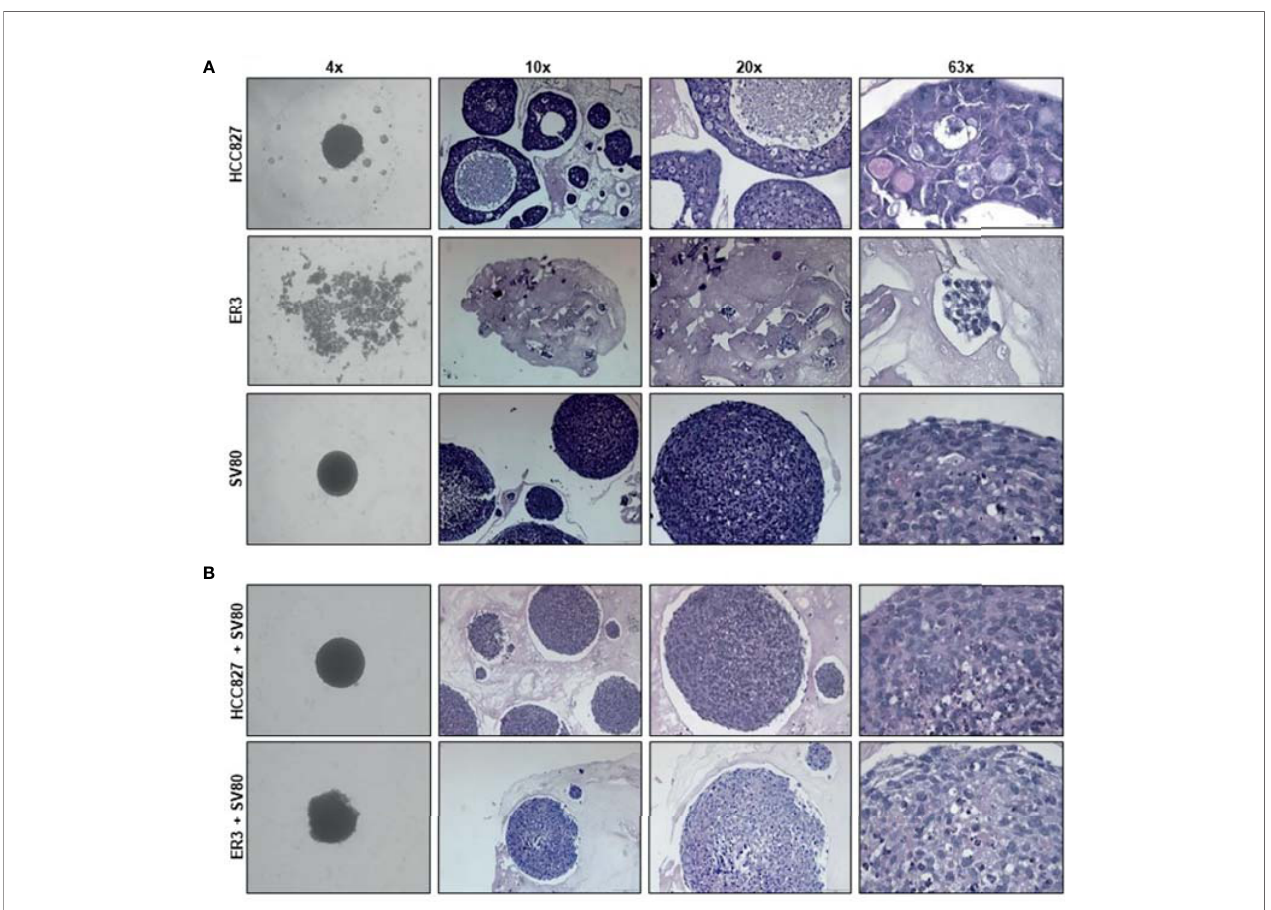
FIGURE 4 | Histological characteristics of homotypic and heterotypic co-culture spheroids. (A) Monoculture spheroids of HCC827 parental cells, the erlotinib- resistant clone ER3, and the fi broblast cell line SV80 were cultured for seven days in ultra-low attachment plates before fi xation, paraf fi n embedding, and sectioning. Spheroids are stained with hematoxylin and eosin (H&E). ER3 cells formed only loosely attached clusters of cells captured in a thrombin gel before paraf fi n embedding. (B) Heterotypic co-culture spheroids consisting of SV80 fi broblasts and HCC827 parental or ER3 cells in a 2:1 ratio. Spheroids were cultured for seven days in ultra-low attachment plates before fi xation, paraf fi n embedding, and sectioning. Spheroids are stained with H&E. The light pink matrix surrounding the loosely attached cell clusters of ER cells, and the spheroids is the serum-thrombin clot used to cast the spheroids. Magni fi cation is